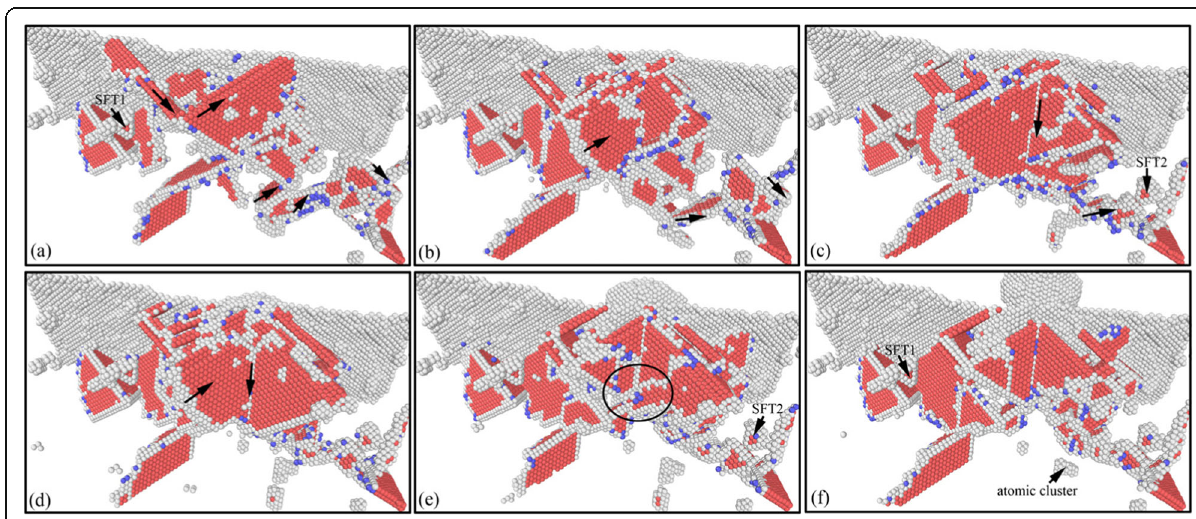
Fig. 9 Subsurface defects evolution in unloading process of nano-indentation (color online). The corresponding indentation depths of a – f are 4 nm, 3 nm, 2 nm, 1 nm, 0 nm, and − 1 nm,